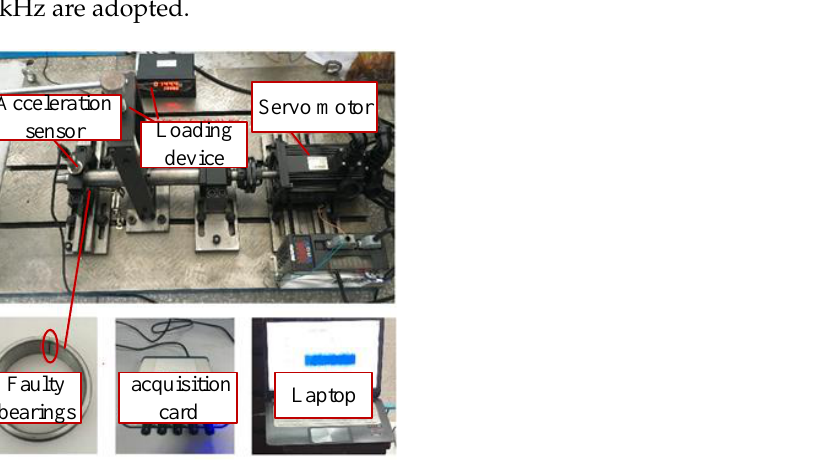
Figure 3. The bearing test bench.